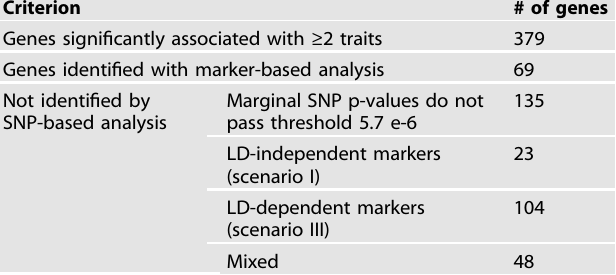
Table 2. Number of genes identi fi ed by gene-based analysis.